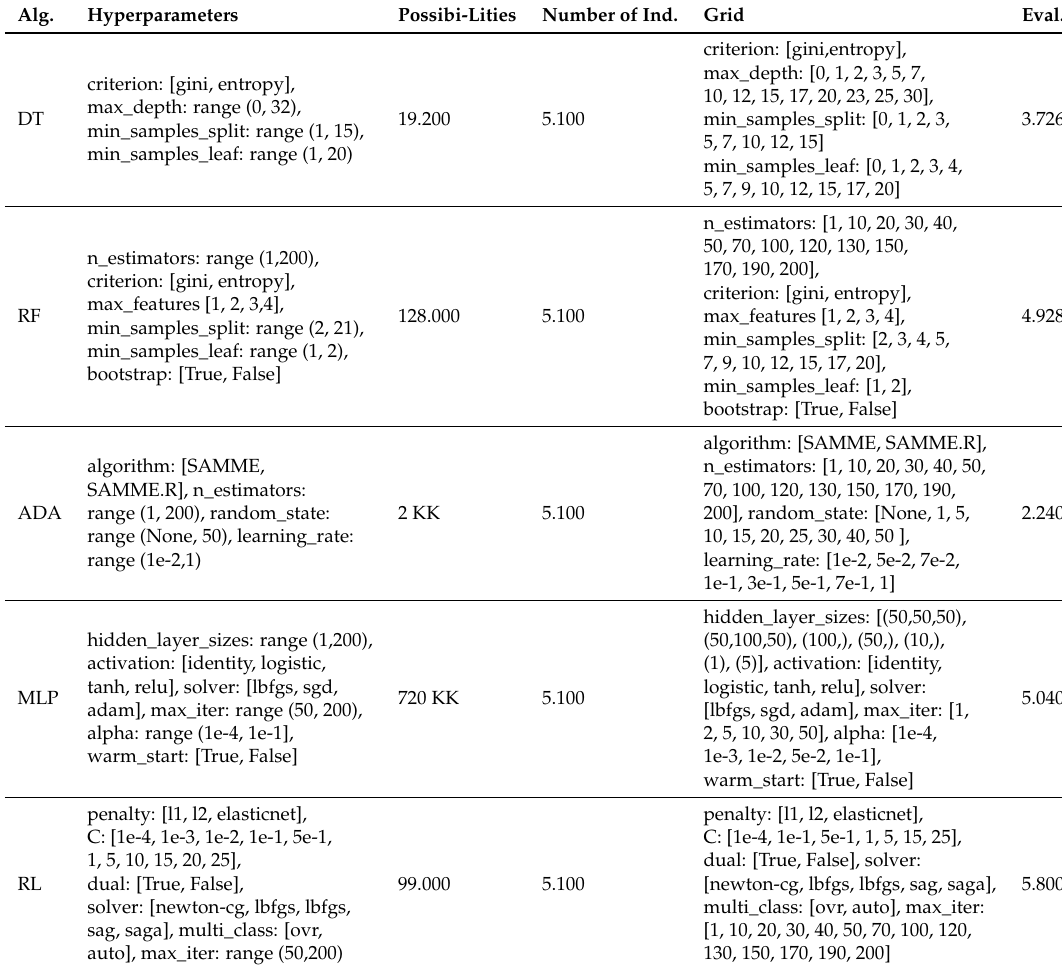
Table A1. Classifiers, Hyperparameters and Number of